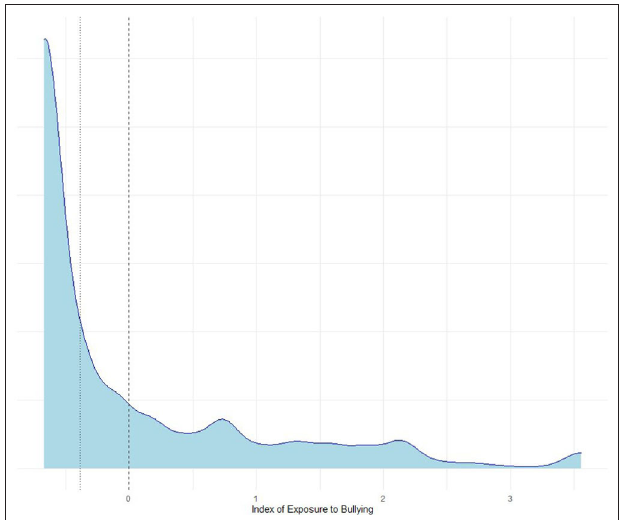
FIGURE 1 | Probability density plot of the index of exposure to bullying. Note: dashed line indicated mean value, whereas the dotted one, median Source: Calculations of the authors based on PISA-2018 in